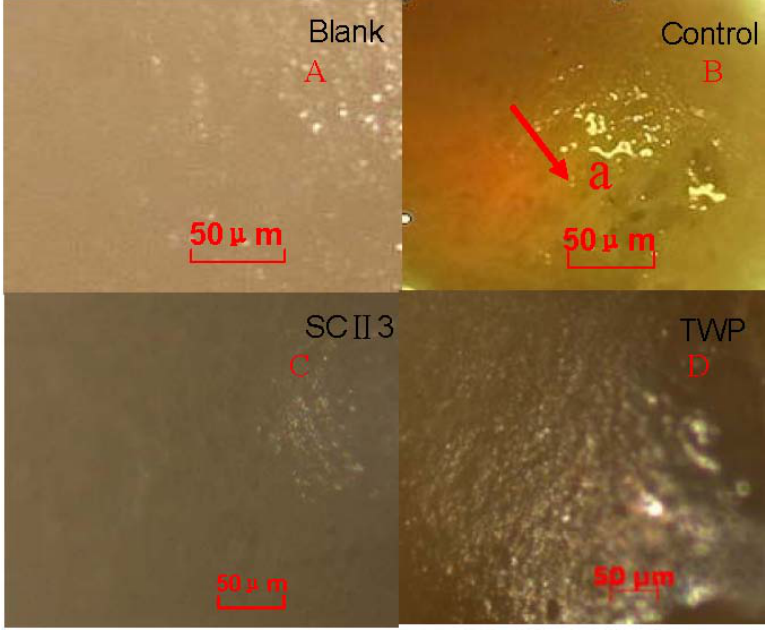
Figure 5. Photos of the articular cartilage surface. ( A ) the articular cartilage surface from rat in blank group; ( B ) the articular cartilage surface from arthritic rat in control group; ( C ) the articular cartilage surface from rat in SCII 3 group; ( D ) the articular cartilage surface from rat in TWP group. ( a ) Synovial membrane